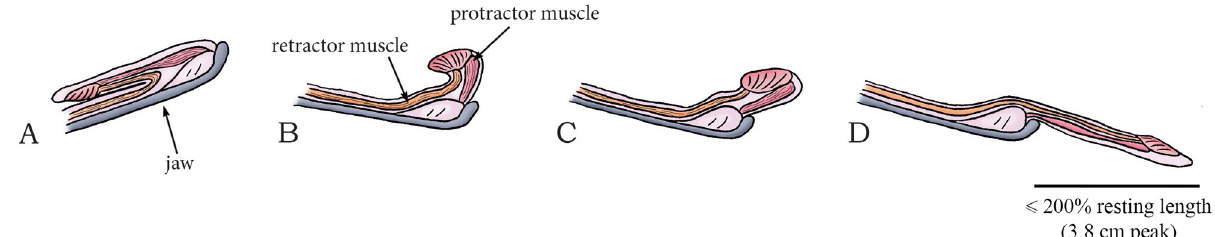
Fig 26. Inertial elongation catapult mechanism in the order Anura (species Bufo marinus ). (A) The jaw and tongue of frogs and toads using the inertial elongation catapult in rest position. (B) Contraction of the protractor muscle moves the tongue up- and forward. (C – D) Rapid jaw depression accelerates and elongates the tongue using the tongue ’ s own inertia. Drawings based on schematic drawings in [16]. Scale bar indicates a length of up to 200% of the resting length (peak launch distance 3.8 cm in Rana pipiens